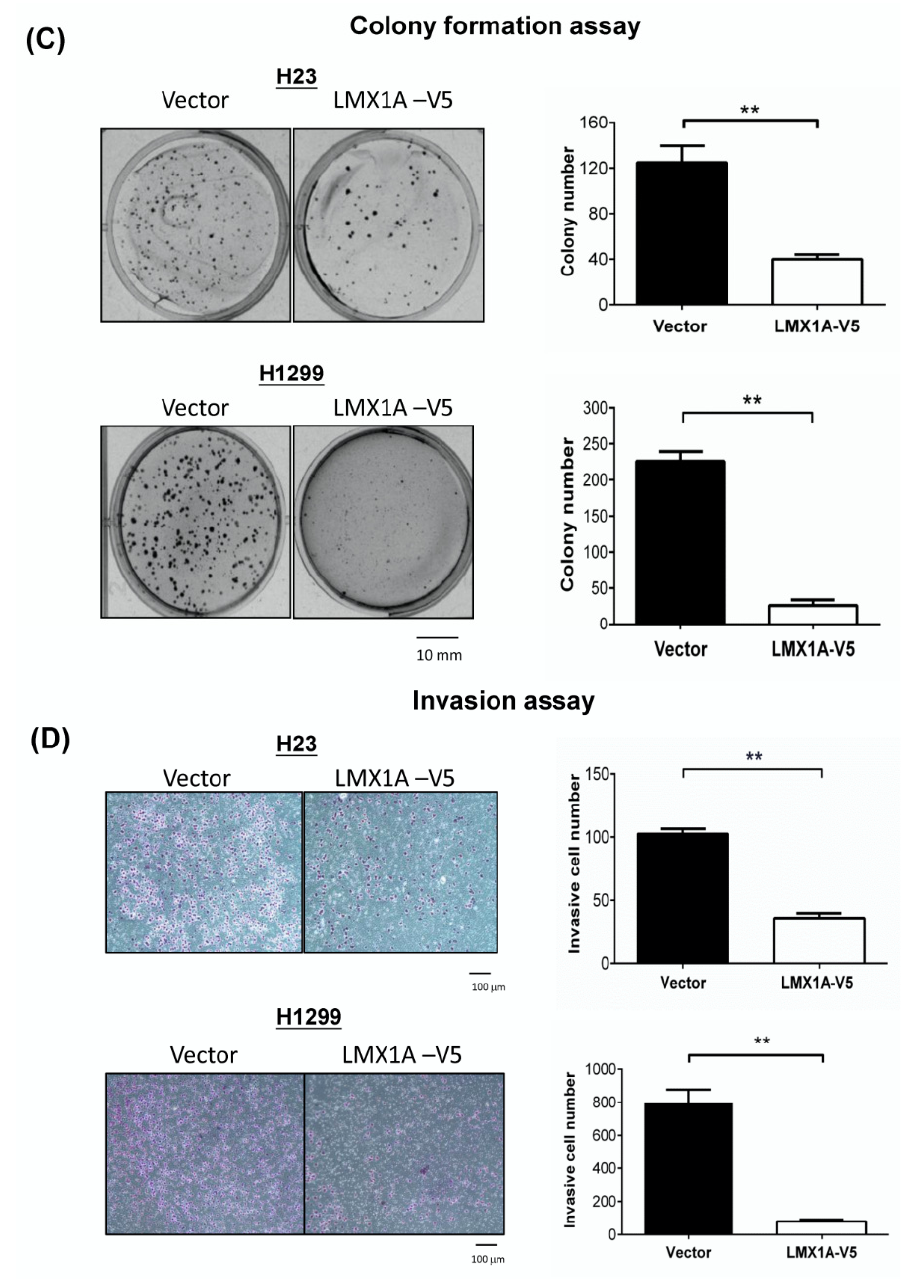
Figure 4. Ectopic expression of LMX1A suppresses the colony formation and invasion of cancer cells in a constitutive expression system. ( A ) Expression of LMX1A in H23 and H1299 NSCLC cell lines stably transfected with LMX1A-V5 or the empty vector (pCDNA3.1) was analyzed by Western blots using an anti-V5 antibody. β -Actin was used as an internal control. ( B ) Cell proliferation (3-(4,5-dimethylthiazol-2-yl)-5-(3-carboxymethoxyphenyl)-2-(4-sulfophenyl)-2H-tetrazolium (MTS)) assays were performed using H23 and H1299 cells expressing LMX1A-V5 or the empty vector. The absorbance values are presented as the mean ± SEM from four independent experiments. ( C ) Colony formation assays were performed using H23 and H1299 cells expressing LMX1A -V5 or the empty vector. ( D ) Matrigel invasion assays were performed using H23 and H1299 cells expressing LMX1A-V5 or the empty vector. These results are presented as the mean ± SEM from three independent experiments in duplicate. ** p < 0.01 (Mann–Whitney U